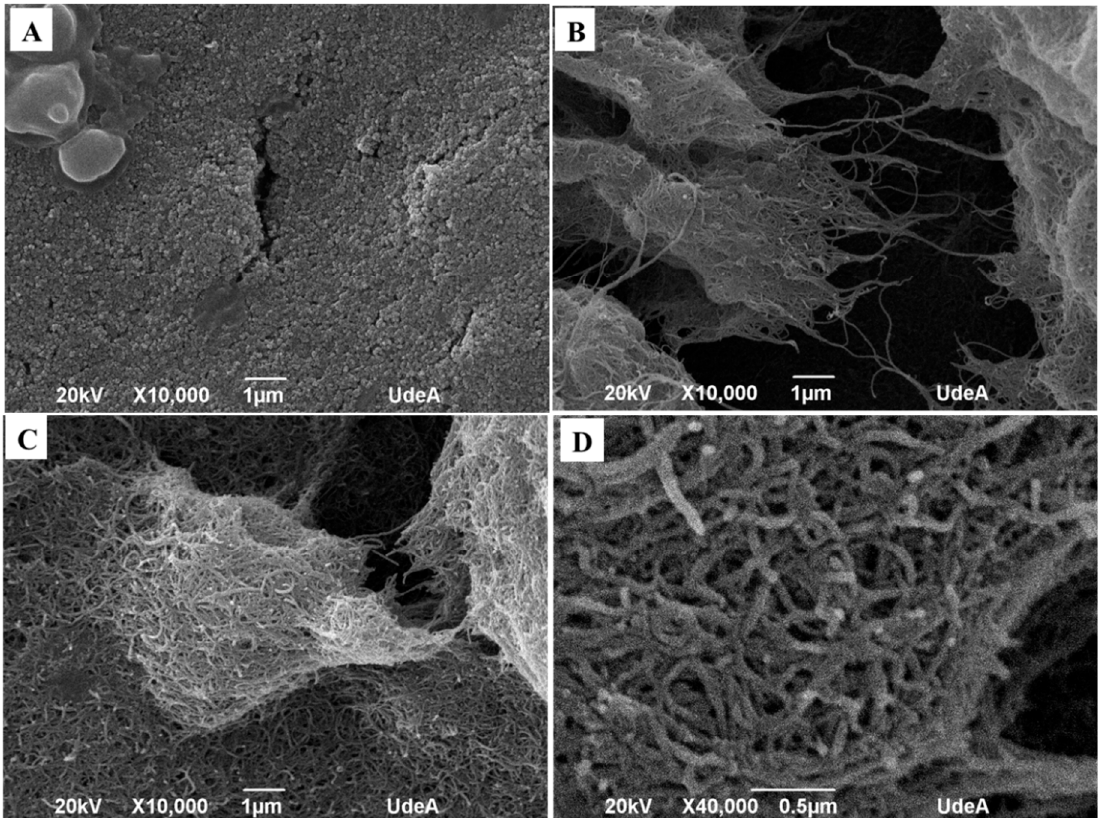
Figure 1. SEM micrographs of: an unmodified screen-printed electrode ( A ); a screen-printed electrode modified with non-oxidized MWCNT ( B ); and screen-printed electrode modified with O-MWCNT with an augment of: × 10,000 ( C ); and × 40,000 ( D ).